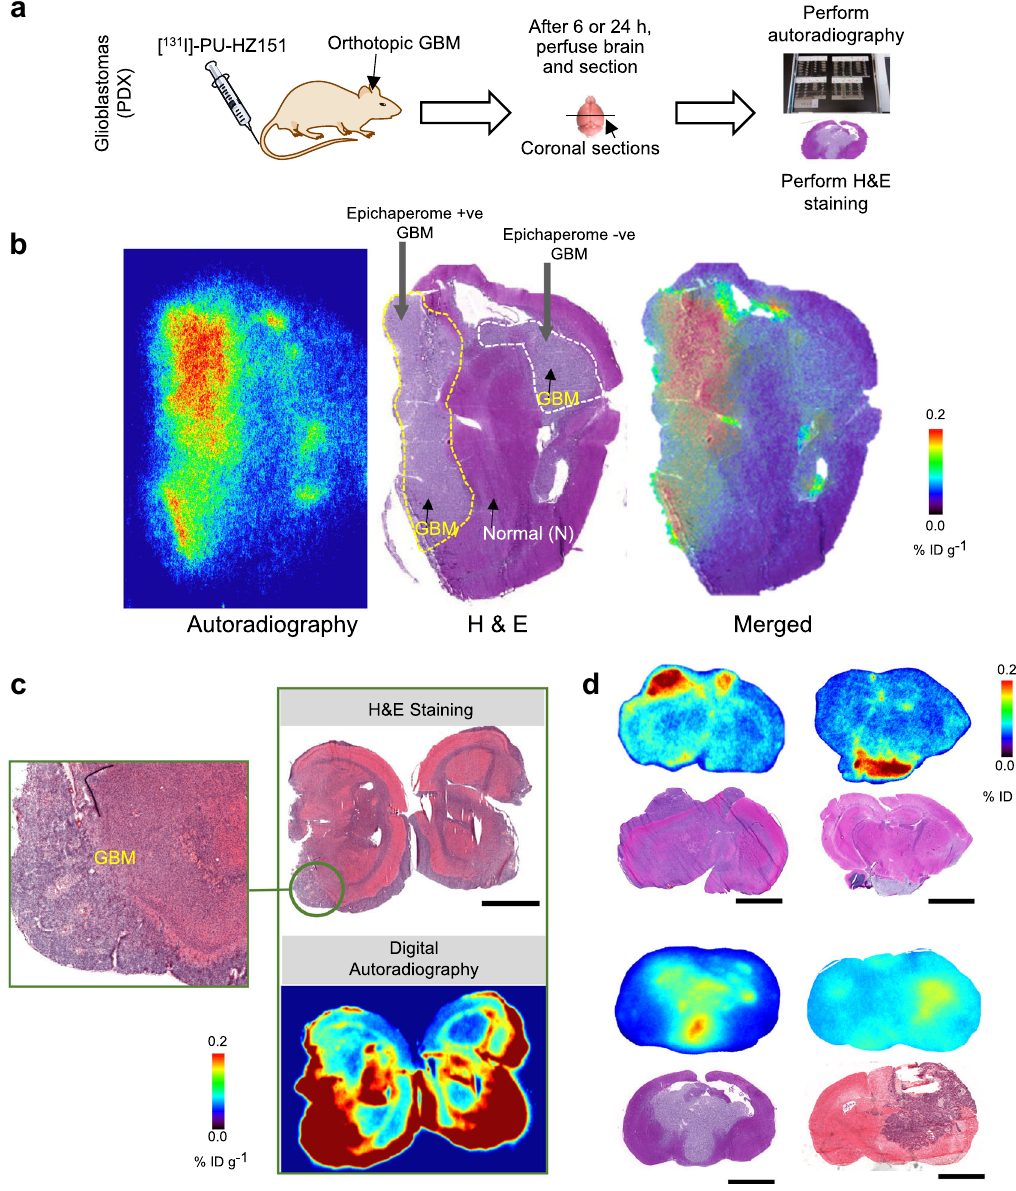
Fig. 5 Radiolabeled PU-HZ151 detects epichaperome-positive glioblastoma patient-derived xenografted tumors. a Experimental design to detect epichaperome-positive glioblastoma multiforme (GBM) lesions and differentiate them from those epichapeorme-negative through autoradiography (AR). H&E was performed to differentiate the normal from the malignancy-af fl icted brain regions. b – d Representative digital AR and H&E staining of brain cryosections. For a , d : 15 μ Ci g − 1 [ 131 I]-PU-HZ151 injected and AR performed at 6 h post-iv injection; for c : 35 µ Ci g − 1 [ 131 I]-PU-HZ151 injected and AR performed at 24 h post-iv injection. Each section is from an individual mouse. For b , both epichaperome-positive and -negative glioma-stem cells were stereotactically injected to form tumors. For c , inset shows a region with highly in fi ltrative GBM. Both epichaperome + ve and -ve GBMs have comparable HSP90 levels, see Fig. 6 and Supplementary Fig. 18. Scale bar, 2